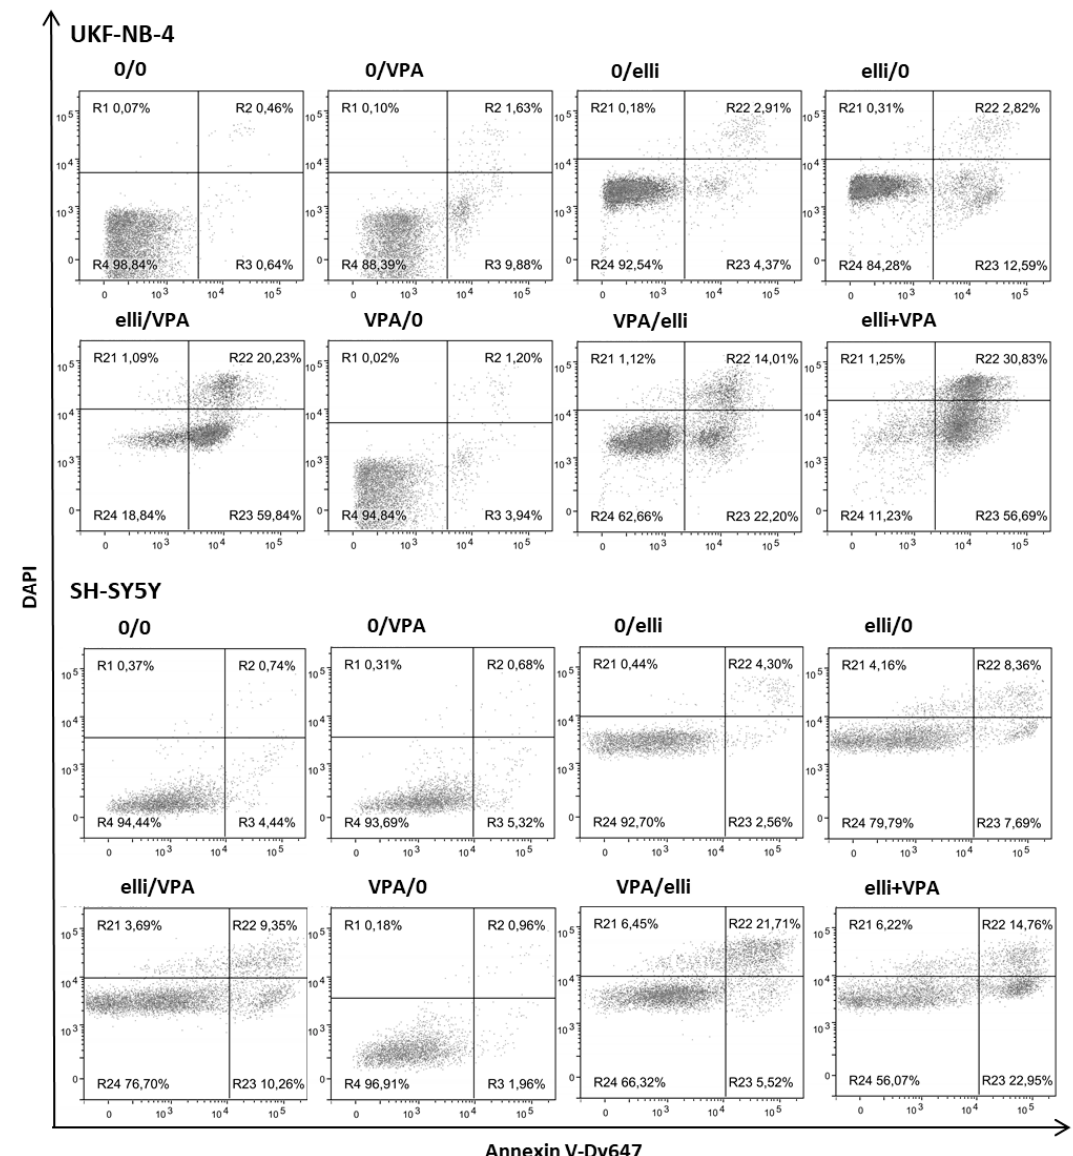
Figure 5. Induction of apoptosis in UKF-NB-4 and SH-SY5Y cells exposed to 1 mM valproic acid (VPA), 5 µM ellipticine (elli) and their combinations. Experimental treatment conditions are described in Table 1. Control cells (0/0) are incubated in medium without drugs. Apoptosis was measured using Annexin V-Dy647/DAPI labeling. Representative data from one of three independent experiments are shown.